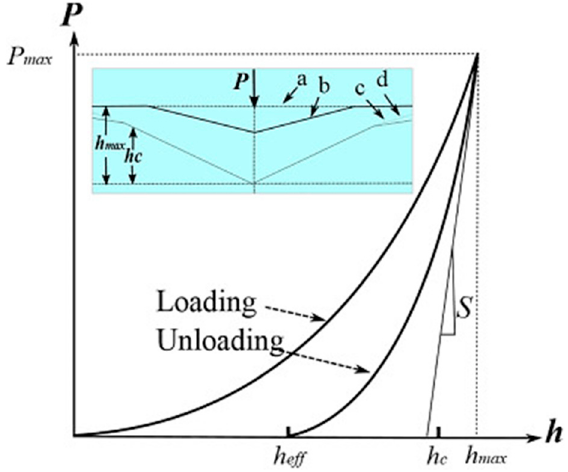
Figure 7. A Schematic representation of a load–displacement curve in indentation testing. ( a ) Initial surface; ( b ) surface after load removal; ( c ) indenter; ( d ) surface profile under load. P is the peak indentation load; h max is the indenter displacement at peak load; h eff is the final depth of contact impression after unloading; and S is the initial unloading sti ff ness. (Reprinted with